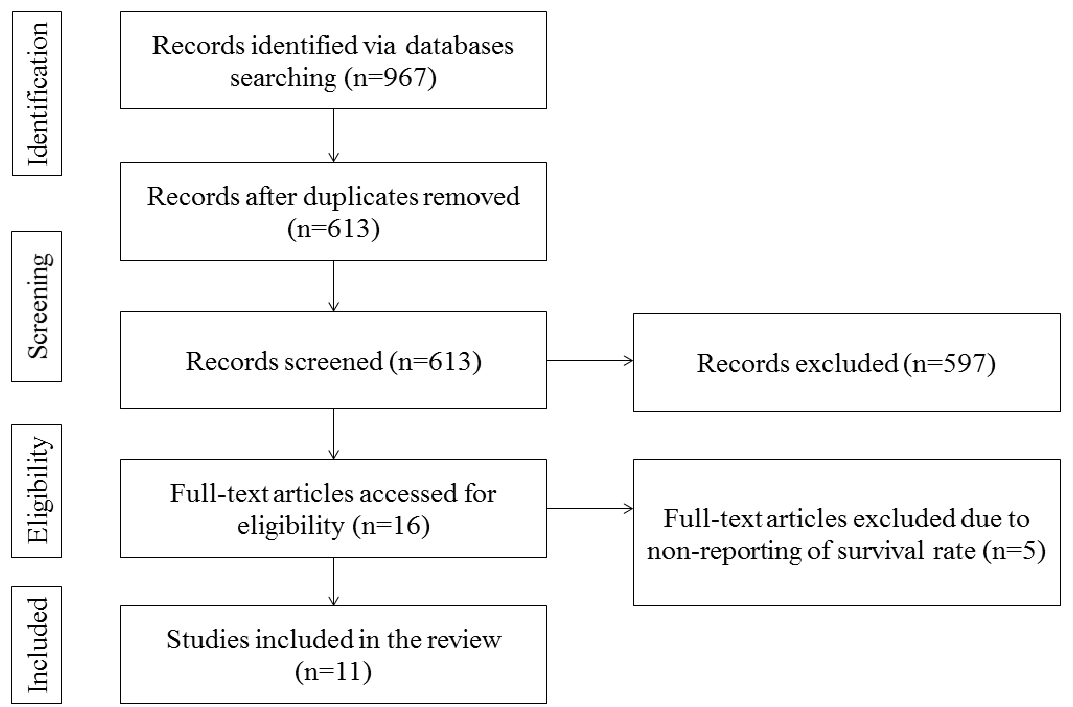
Figure 1. Prisma flow diagram for study methodology.